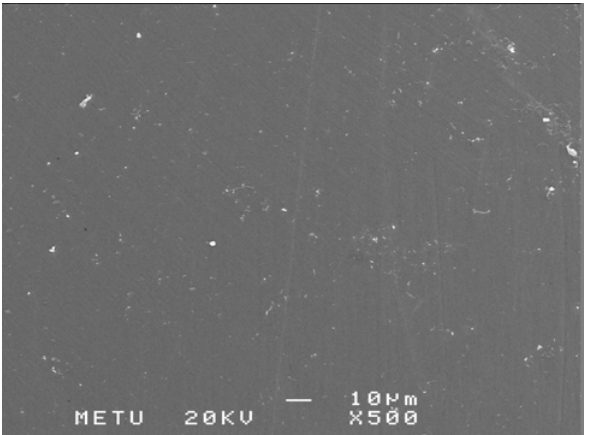
FIGURE 6- SEM analysis after residual remnants removal with silicone carbide impregnated one-step OptiShine brush